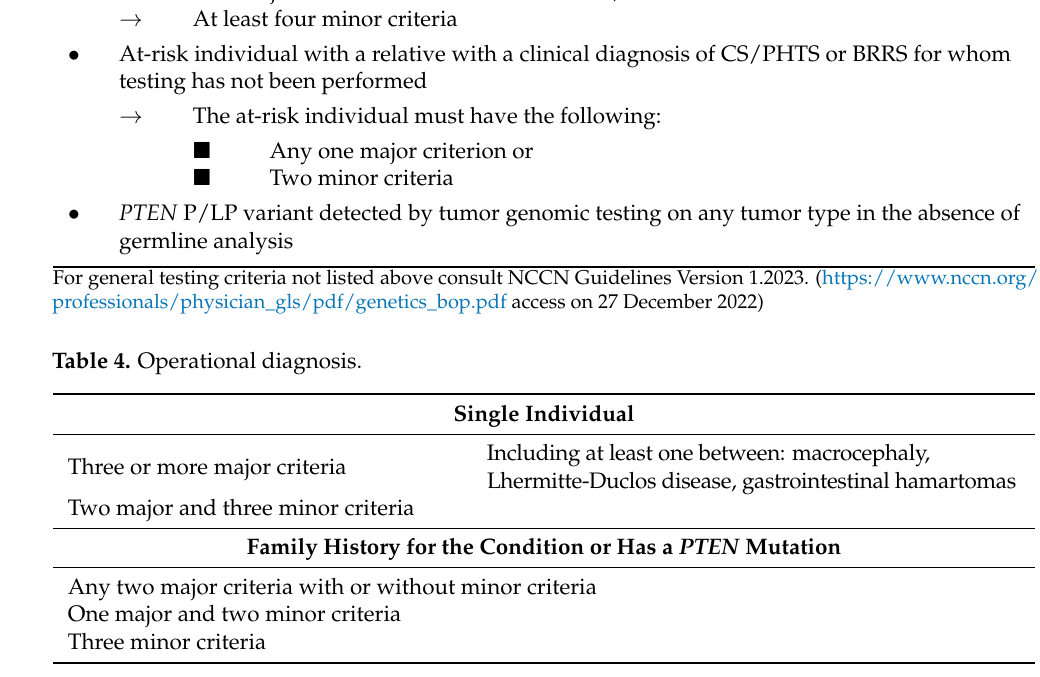
Table 5. Danish guidelines for the cancer surveillance of patients with germline PTEN mutation. Surveillance